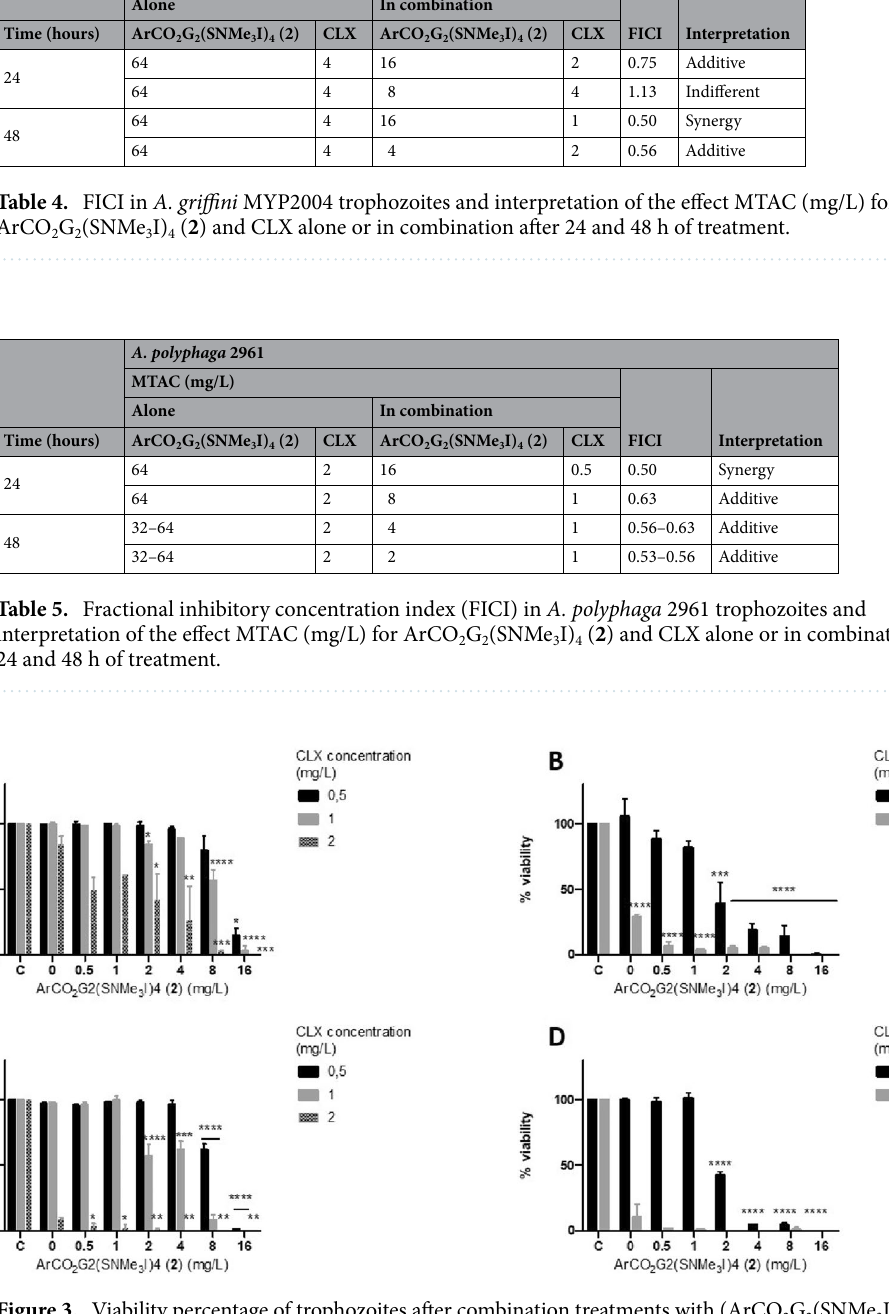
Figure 3. Viability percentage of trophozoites after combination treatments with (ArCO 2 G 2 (SNMe 3 I) 4 ( 2 ) and CLX. ( A ) A. griffini MYP2004 24 h treatment, ( B ) A. polyphaga 2961 24 h treatment, ( C ) A. griffini MYP2004 48 h treatment, ( D ) A. polyphaga 2961 48 h treatment. * p ≤ 0.05; ** p ≤ 0.01; *** p ≤ 0.001; **** p ≤